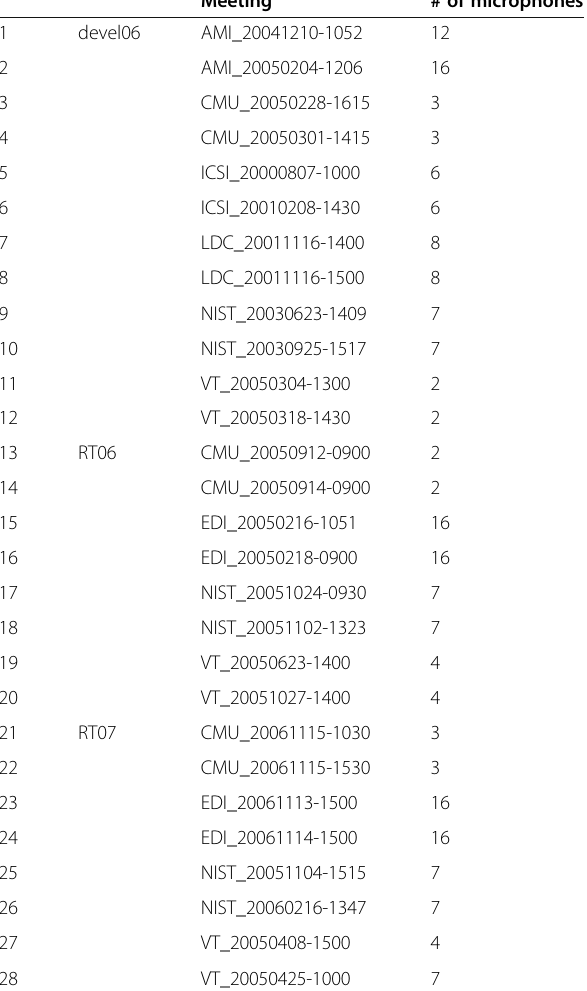
Table 1 List of meetings used for the development set (DEVELS